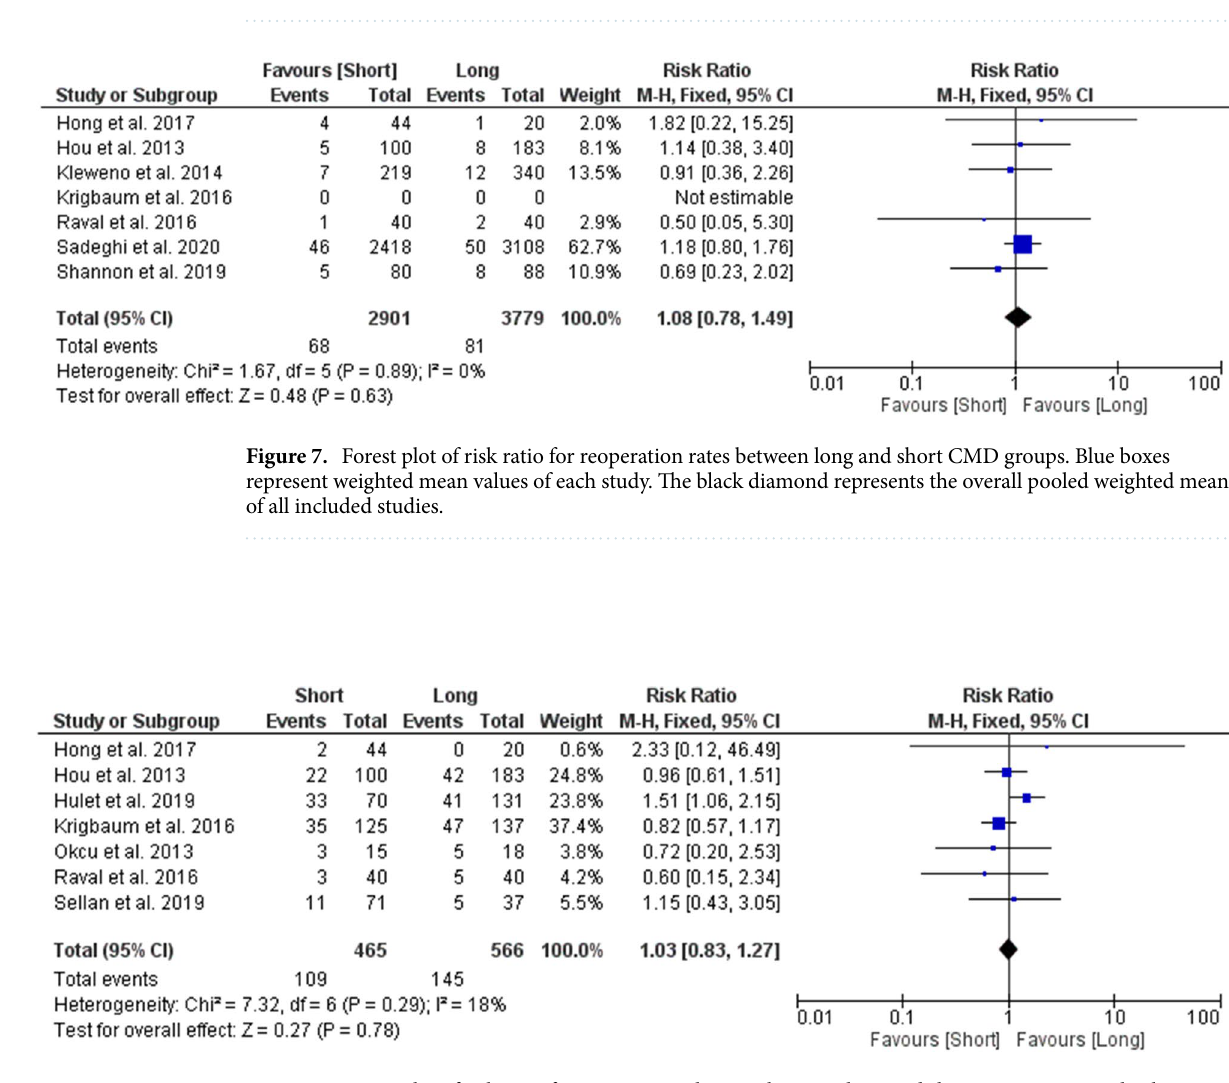
Figure 8. Forest plot of risk ratio for 1-year mortality rate between long and short CMD groups. Blue boxes represent weighted mean values of each study. The black diamond represents the overall pooled weighted mean of all included